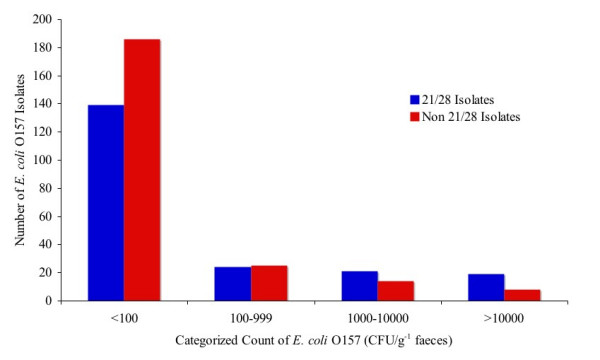
Comparison of the categorised count of E. coli O157 for samples containing PT 21/28 and non-PT 21/28 E. coli O157 isolates.